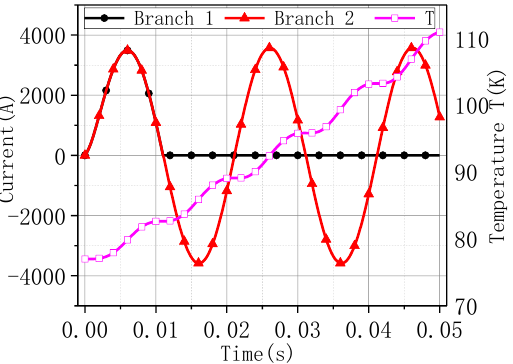
Figure 17. Current and temperature curves of parallel inductance during a fault.